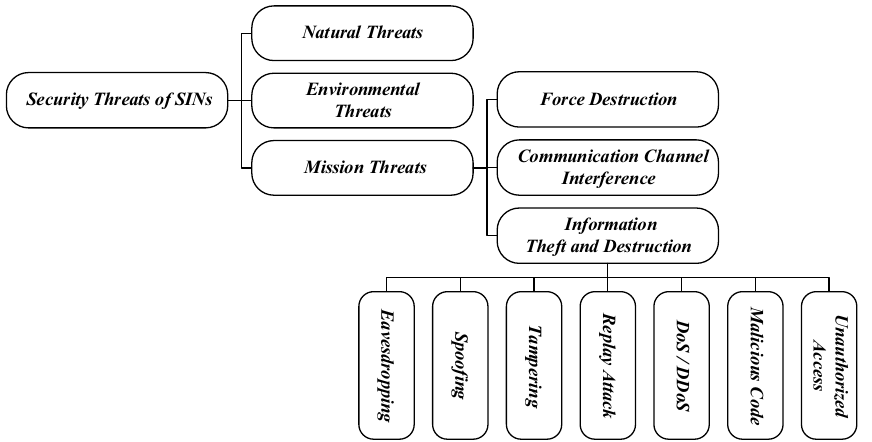
Figure 1. The SINs contain three types of threats: natural threats, environmental threats, and mission threats.